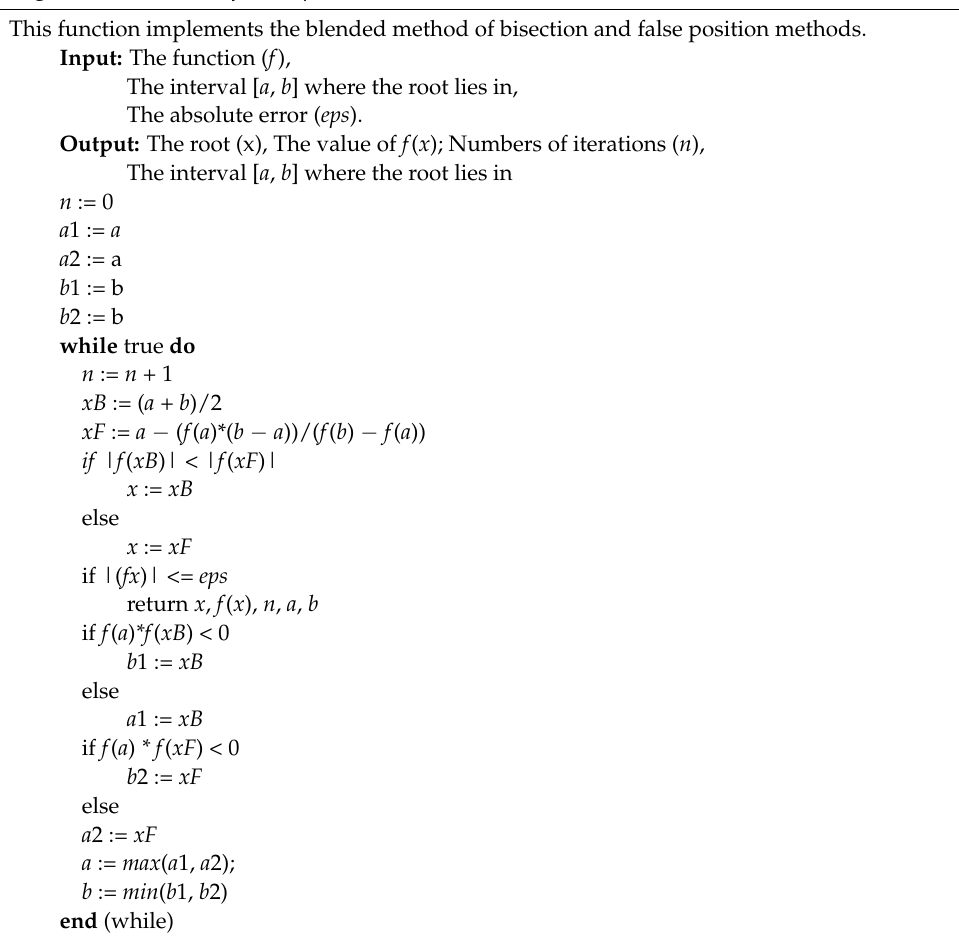
Algorithm 6. blendBF( f , a , b , eps